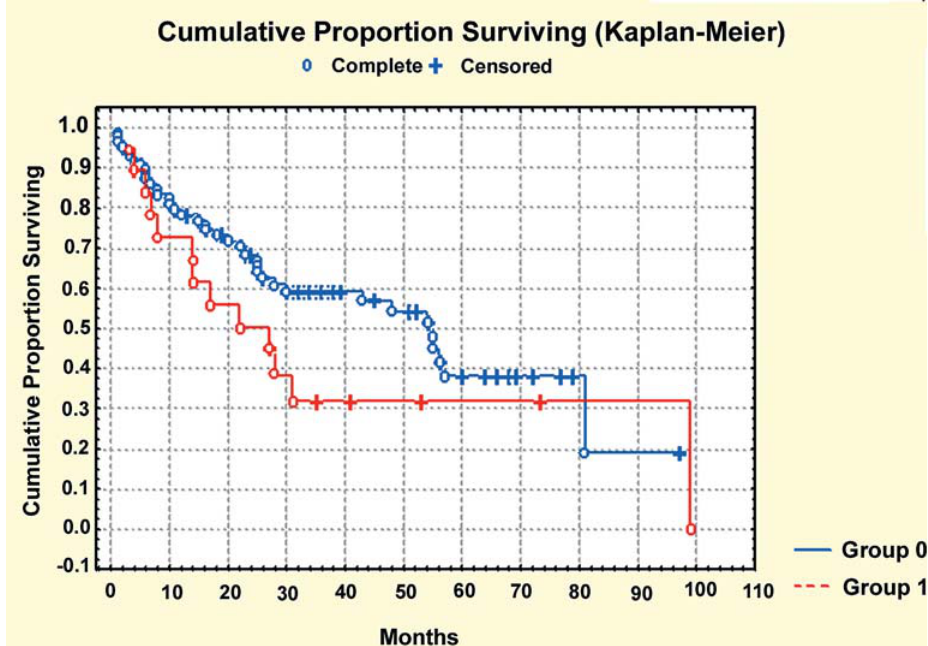
Figure 2 – Time to biochemical (PSA) progression-free survival comparing Gleason 3+4 (group 0) vs. Gleason 4+3 (group 1) in the surgical specimen. Kaplan-Meier product-limit